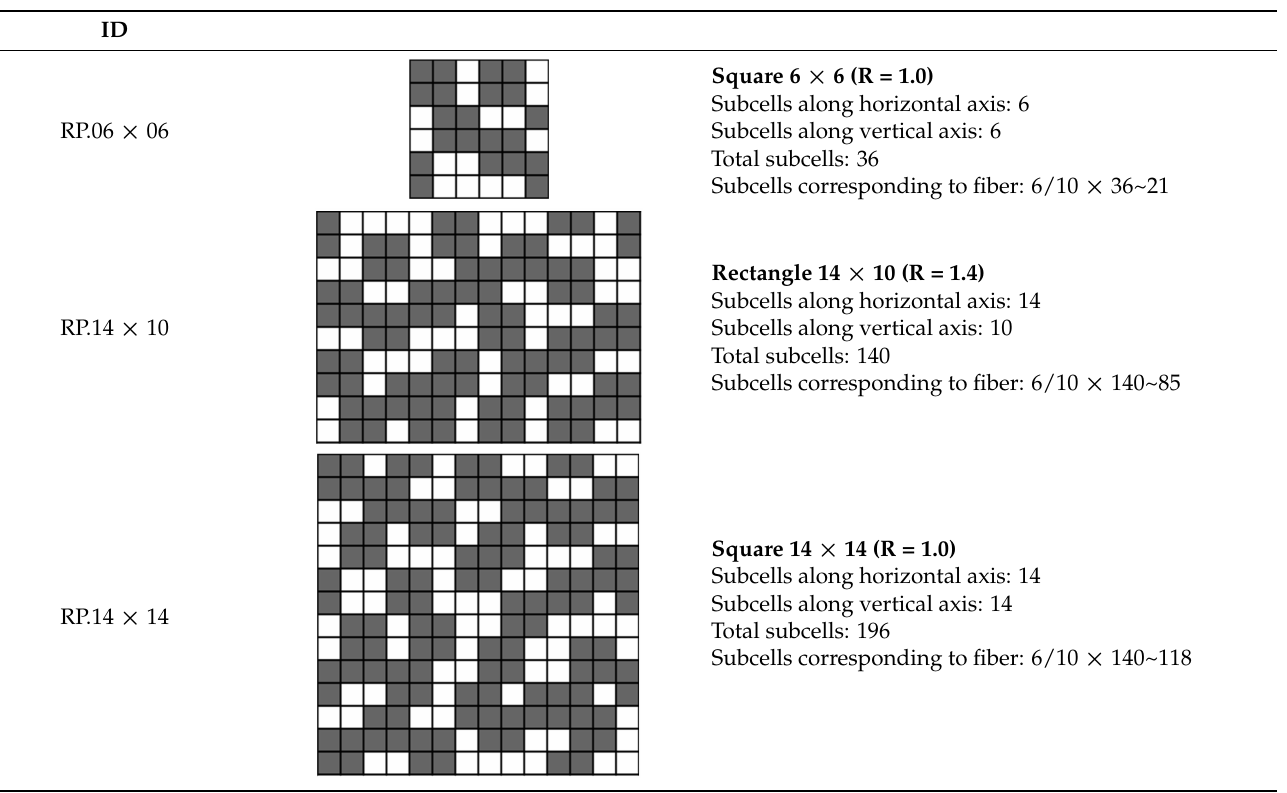
Table 2. Random packing arrangements with constant fiber volume fraction V f =